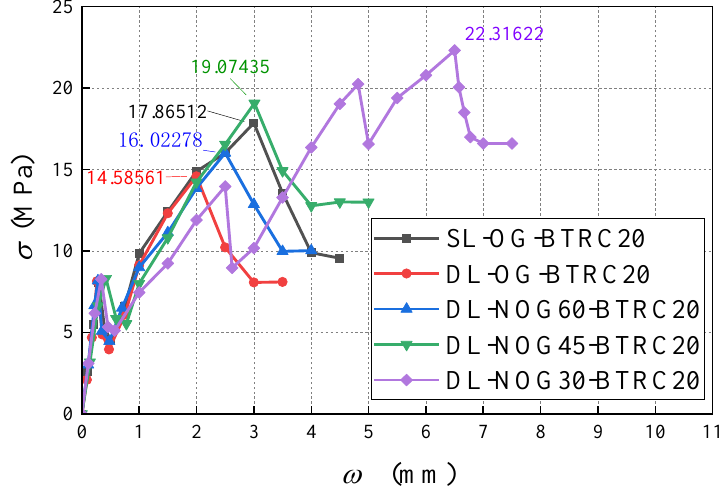
Figure 10. Bending stress – midspan deflection curve of